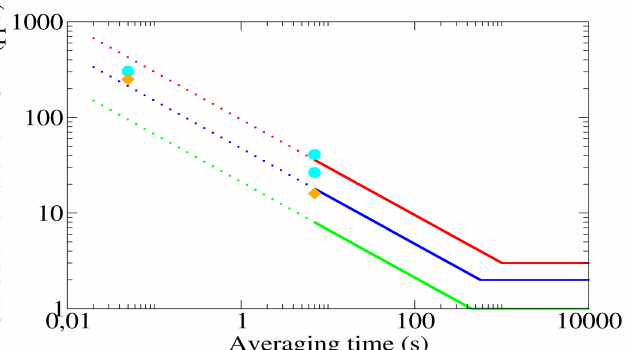
Figure 26. MERLIN performances estimated with LIDSIM and PROLID (the red/blue/green curves correspond to the threshold/breakthrough/target performances, respectively). The cyan dots rep- resent the tests described in Section 4.3 (at the shot and cell level before and after removing the statistical bias), and the orange diamonds represent the results obtained in this section (for one shot and for one